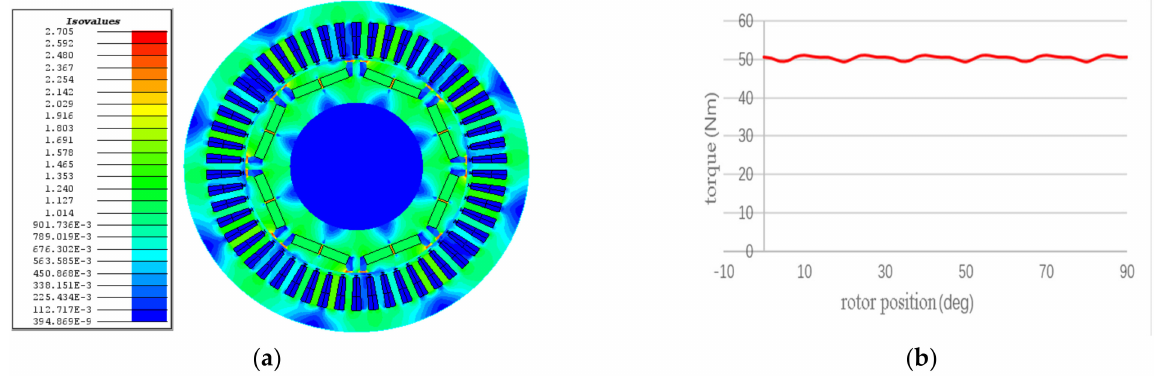
Figure 4. ( a ) Load magnetic density cloud; ( b ) Torque